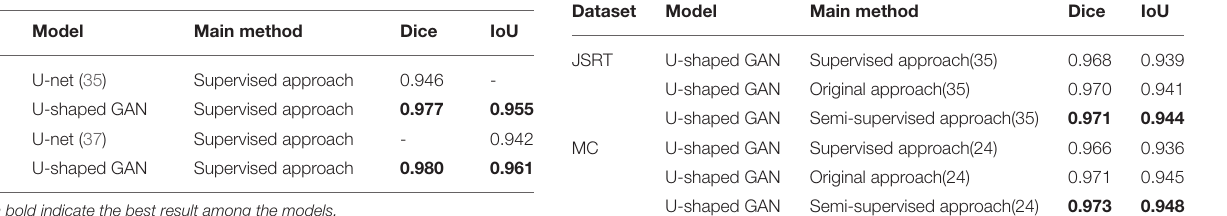
TABLE 5 | Comparison of U-shaped GAN and U-net trained with the whole dataset.